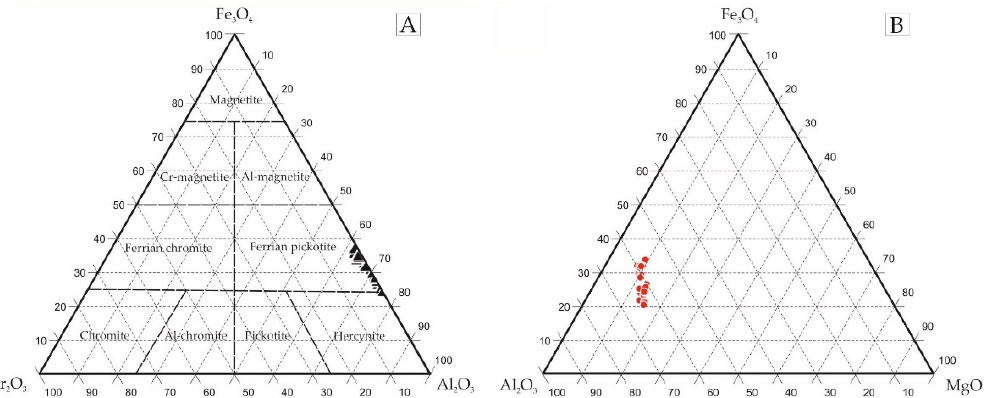
Figure 10. Ternary diagrams of the chemical composition of Al-spinels in the Fe 3 O 4 -Al 2 O 3 -Cr 2 O 3 ( A ) and Fe 3 O 4 -MgO-Al 2 O 3 ( B ) from the Krzemianka and Udryn Fe-Ti-V deposits in NE Poland.